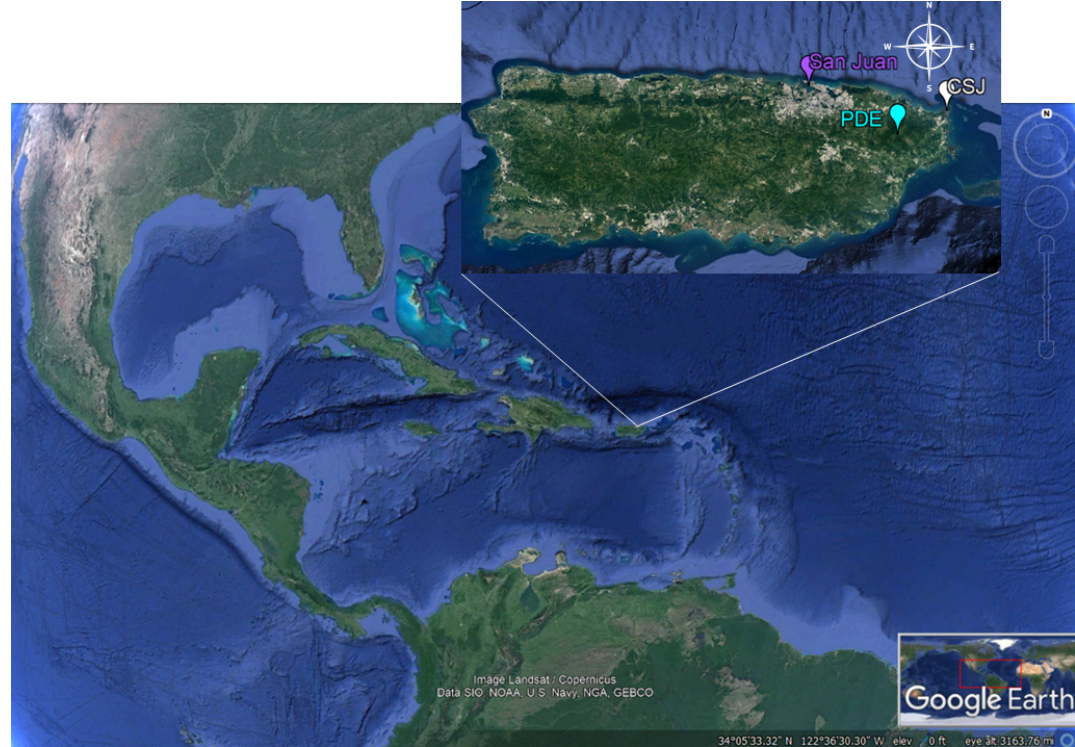
Figure 1. Map of the Caribbean Basin with a zoom over Puerto Rico. The San Juan metropolitan area, CSJ, and PDE stations are highlighted in the map. This figure was generated using © Google Earth Pro